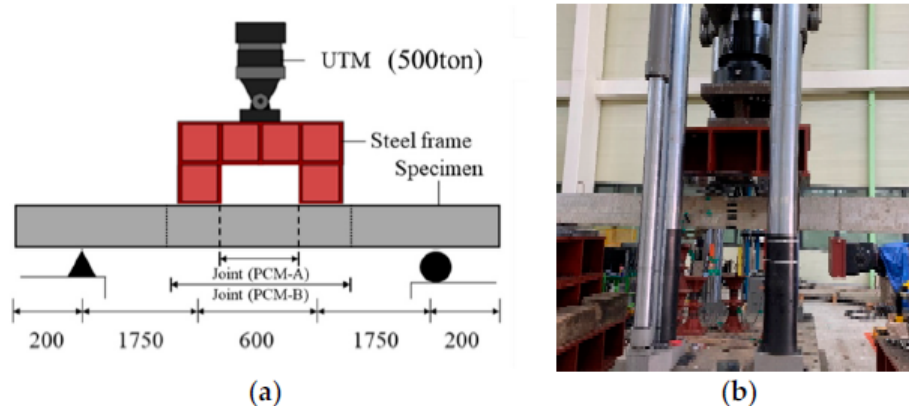
Figure 9. Test setup for flexural test: ( a ) schematic test setup (mm); ( b ) view of test